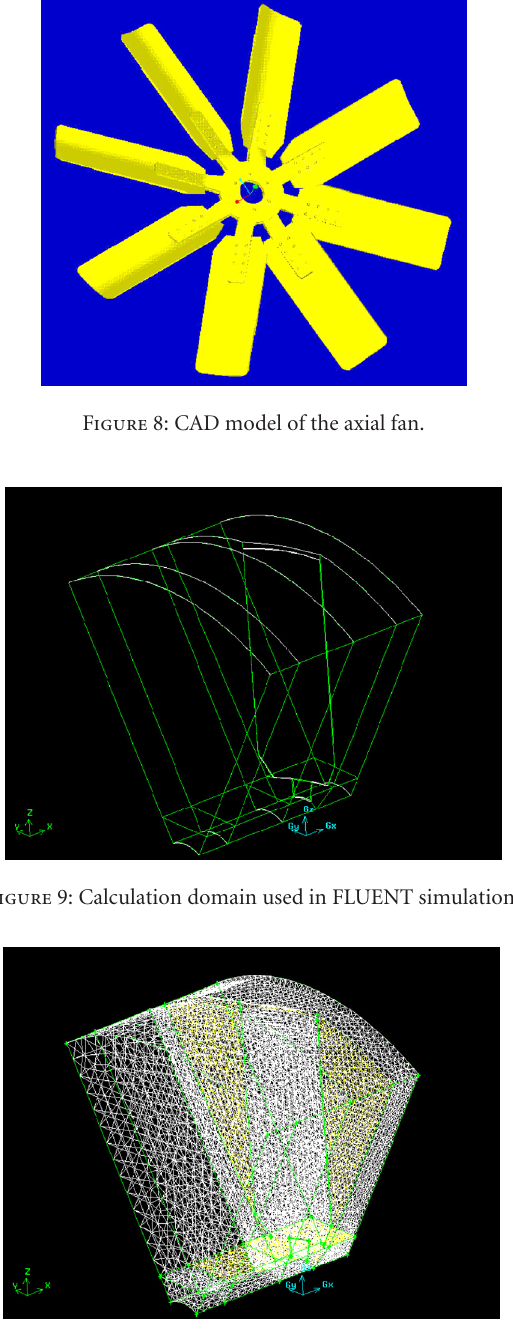
Figure 13: Static pressure on the pressure side and top face of the domain without radiator (unit in